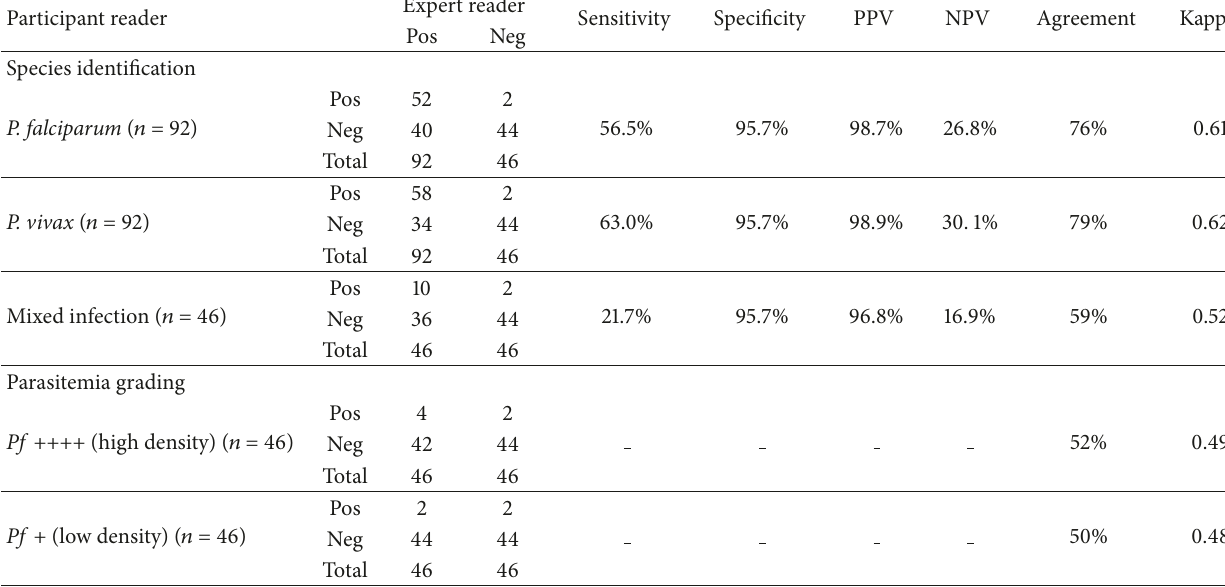
Table 3: Performance of laboratory personnel to correctly identify and quantify malaria slides, Tigray, North Ethiopia, 2016. Participant